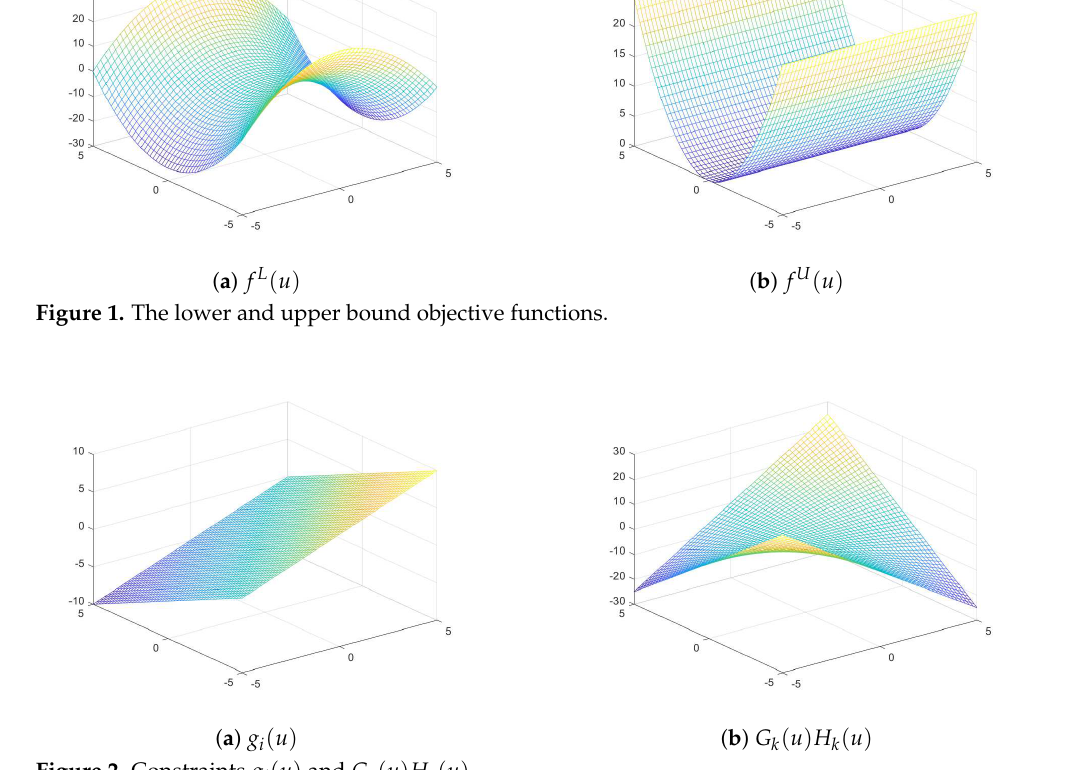
Figure 2. Constraints g i ( u ) and G k ( u ) H k ( u )